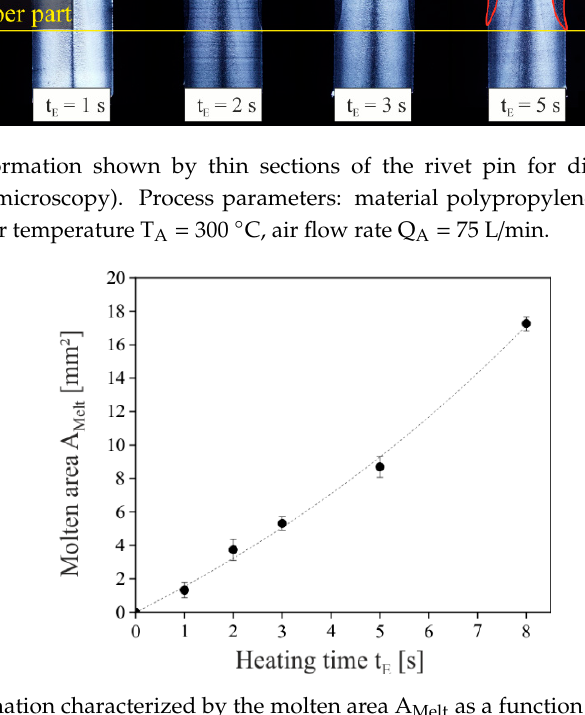
Figure 4. Melt formation characterized by the molten area A Melt as a function of the heating time t E , the molten area is associated with Figure 3.